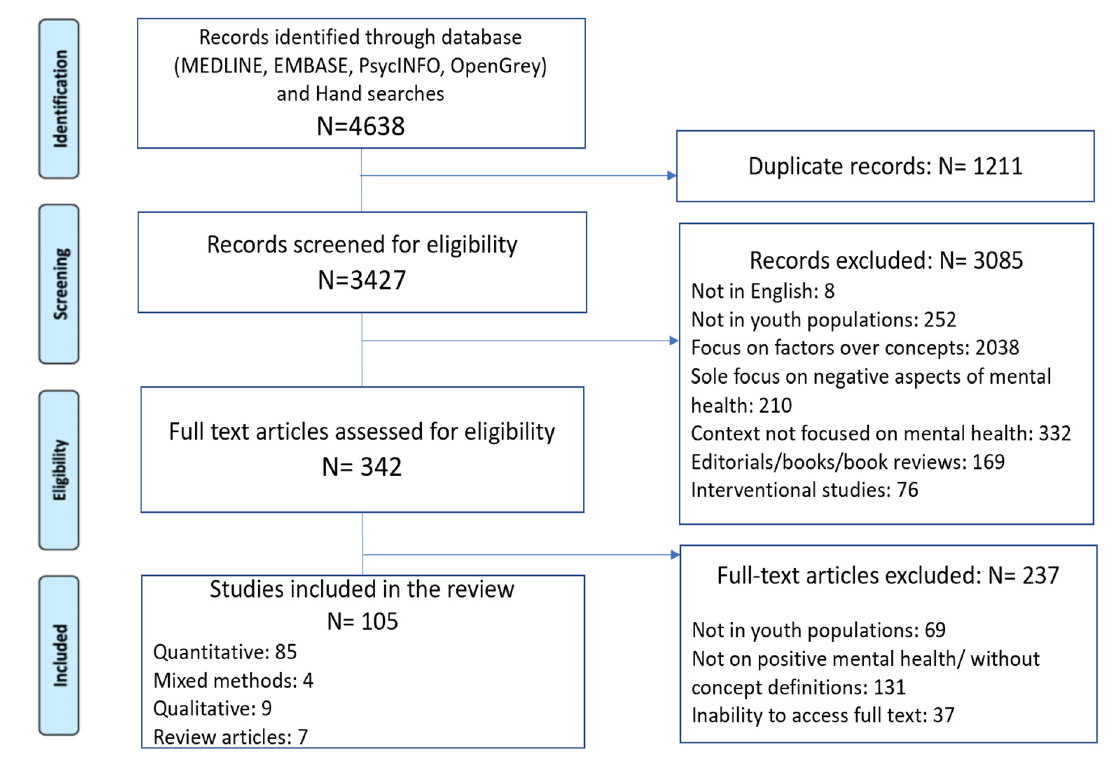
Figure 1. PRISMA flow chart of search results.